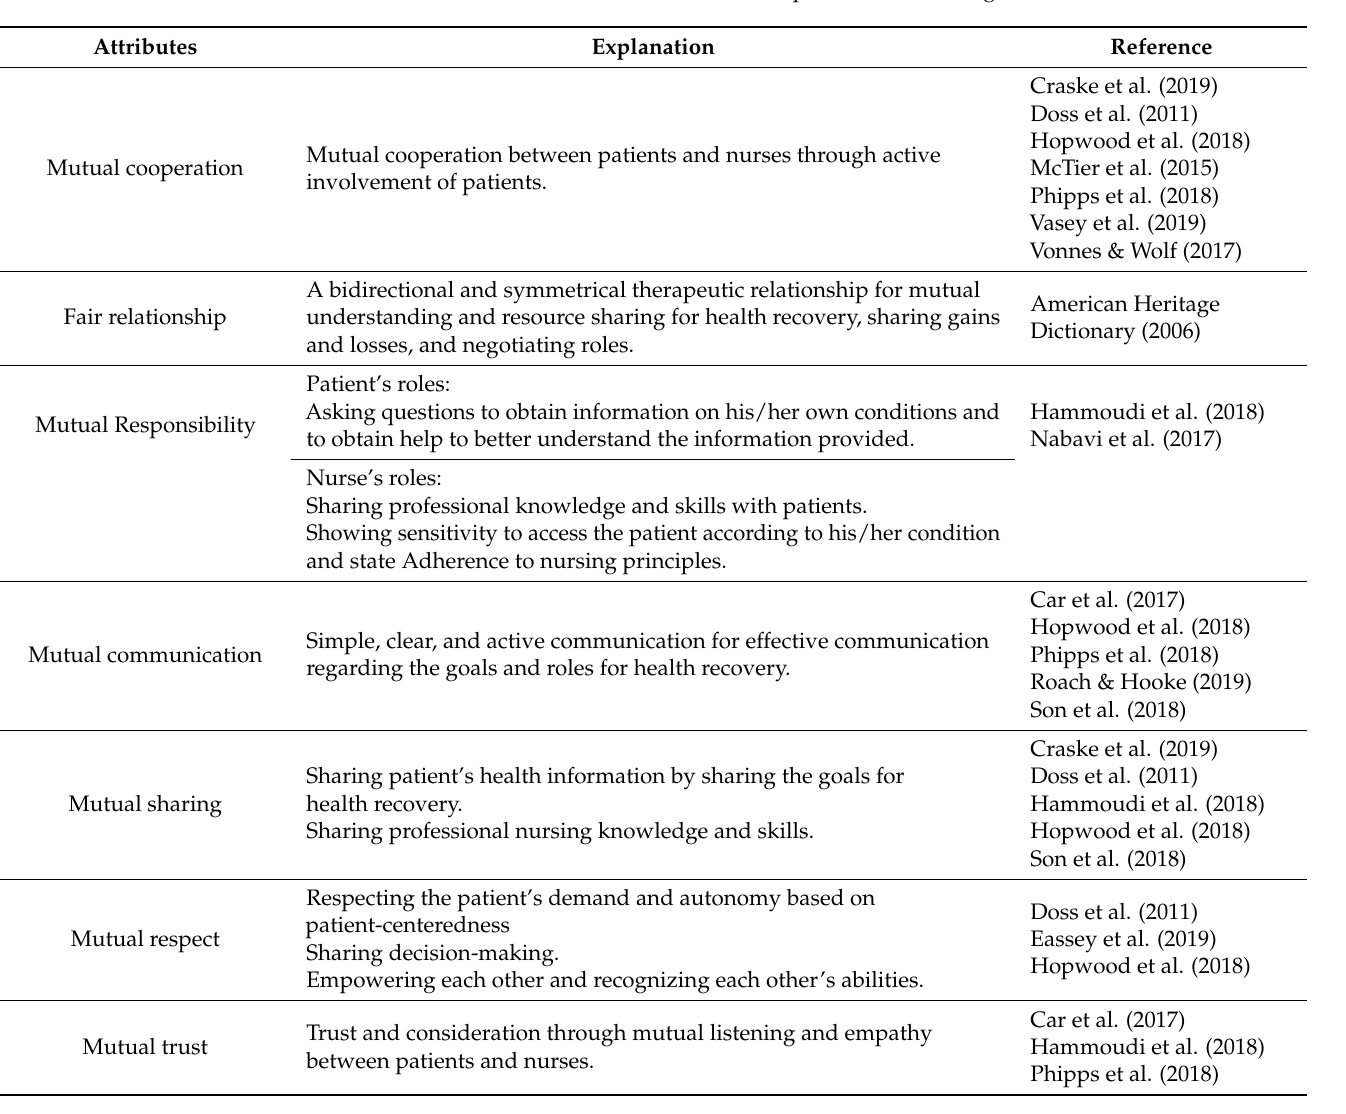
Table 2. Attributes of Patient–Nurse Partnership in Theoretical